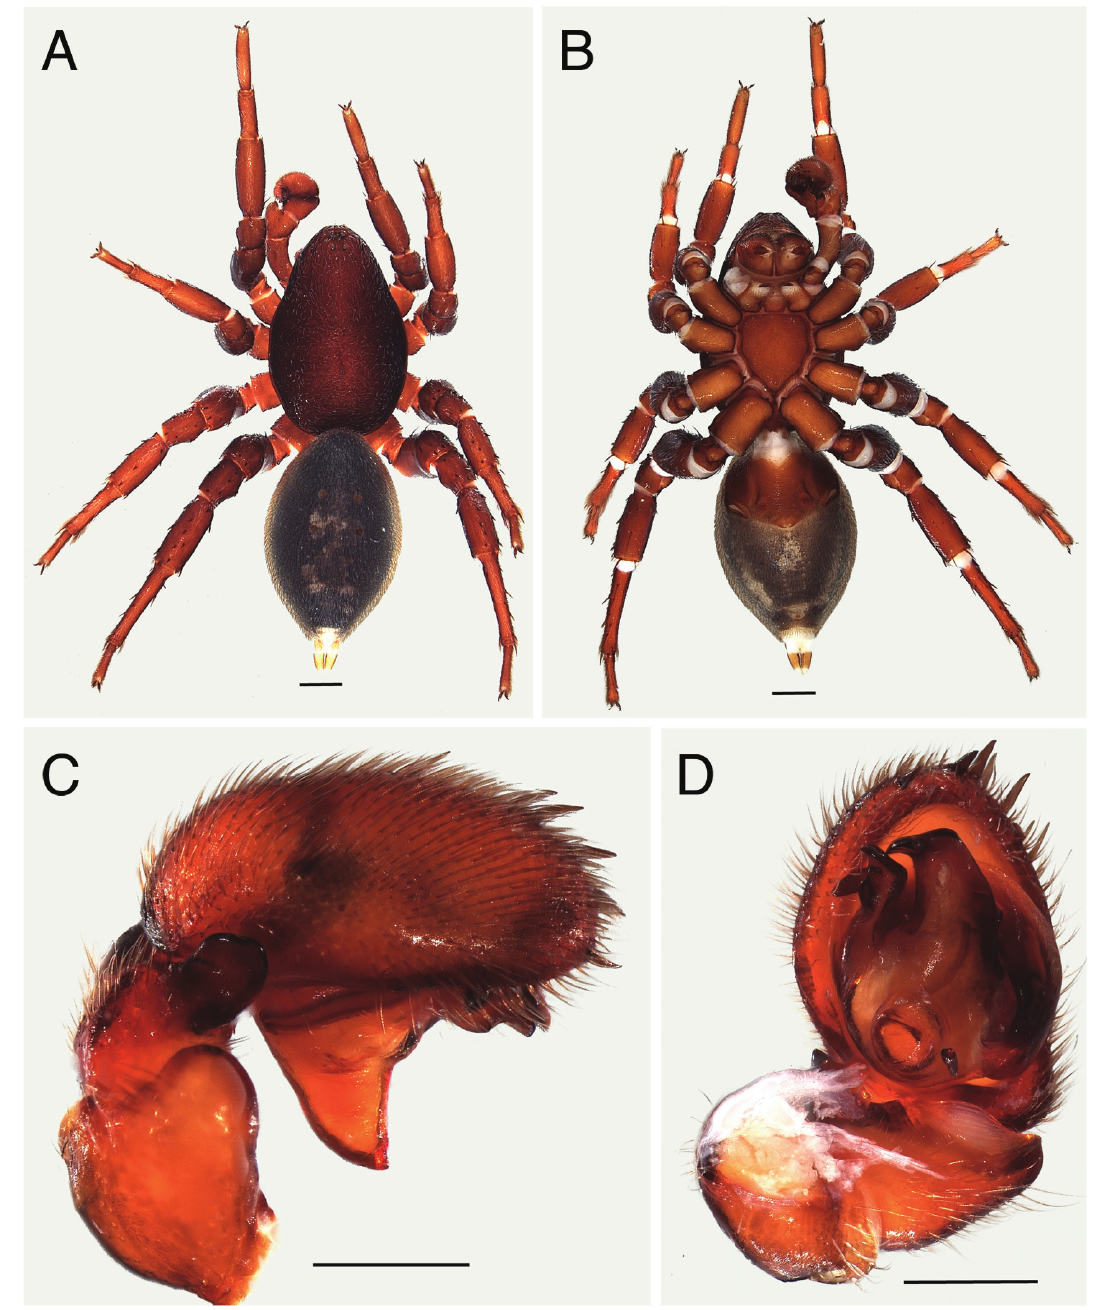
Fig. 6. Palindroma aleykyela gen. et sp. nov., holotype, ♂. A . Habitus, dorsal view. B . Idem, ventral view. C . Palp, retrolateral view. D . Idem, ventral view. Scale bars: A–B = 1 mm, c–d = 0.5